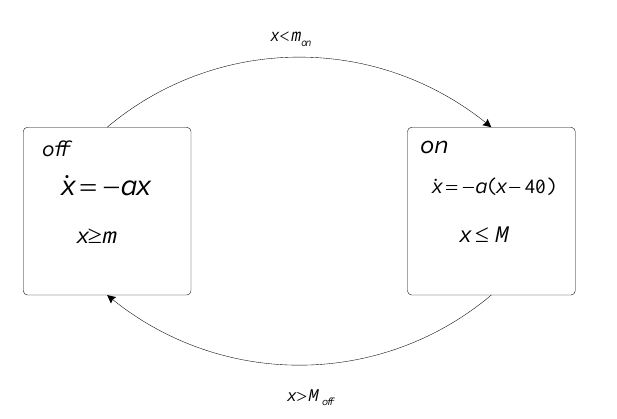
Figure 1. Automaton of a thermostat.